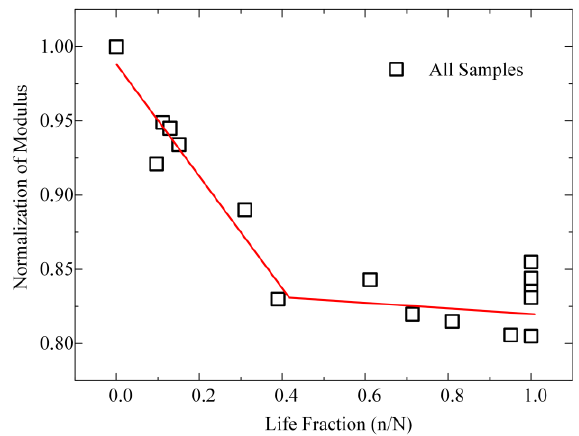
Figure 4. Normalization of the reduced modulus and loading cycles.